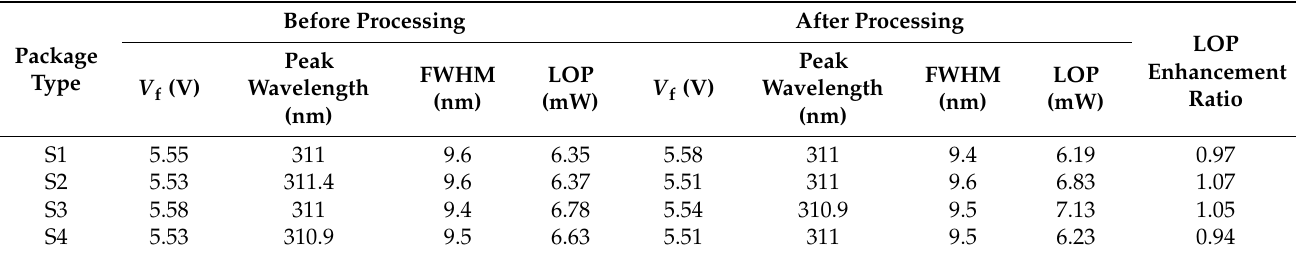
Table 1. Variations in the values of V f , the EL peak wavelength, the EL FWHM, and the LOP of samples S1–S4 measured at 100 mA, before and after encapsulating with silicone and covering with quartz